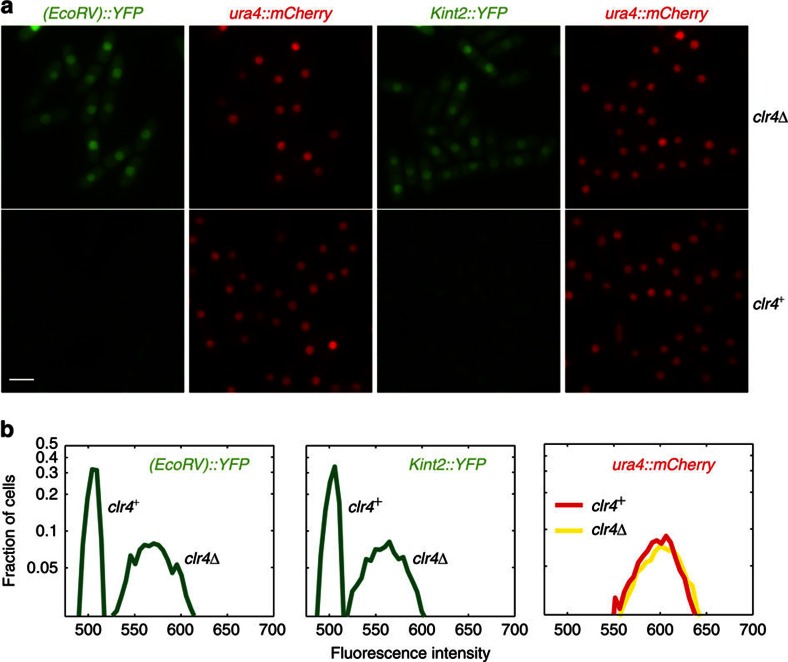
Development of fluorescent reporters for single-cell measurements.A nuclear-targeted YFP under control of the ura4+ promoter was expressed from two sites in the mating-type region, respectively, (EcoRV) near the centromere-distal edge of the heterochromatic region and kint2 within the cenH element. The location of these sites is depicted in Figs 3 and 4. mCherry was expressed in the same cells from the ura4+ euchromatic locus. (a) Fluorescence of kint2::YFP, (EcoRV)::YFP and ura4::mCherry in clr4Δ and clr4+ cells. Scale bar, 5 μm. (b) Distribution of fluorescence intensities for the same strains, obtained by measuring nuclear fluorescence in microscopy images.